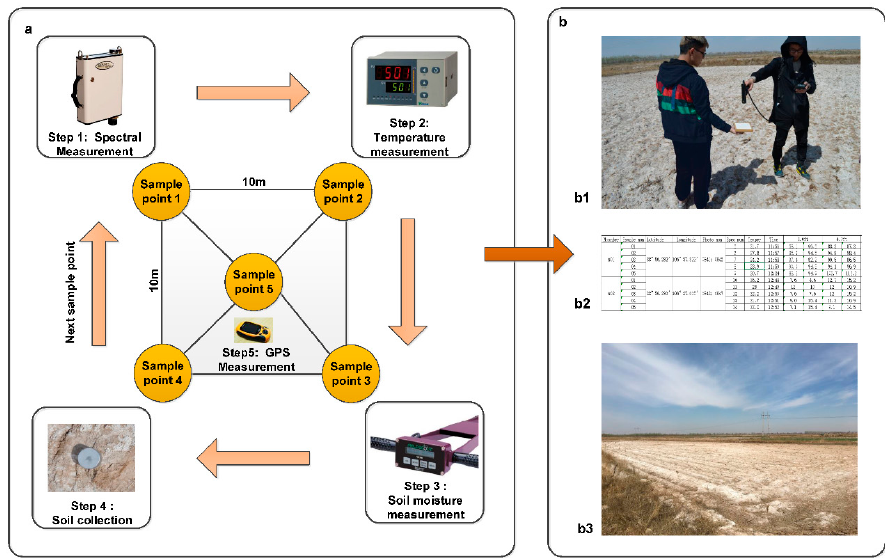
Figure 2. Field data measurement. ( a ) The steps of the field data collection; ( b1 ) the spectrum measurement photo, ( b2 ) the record of the collected data, and ( b3 ) the saline-alkali photo of one of the data collection sites. The white matter on the land-like snow was the salt on the surface of the land, indicating that the salinization of this cultivated land was very serious.